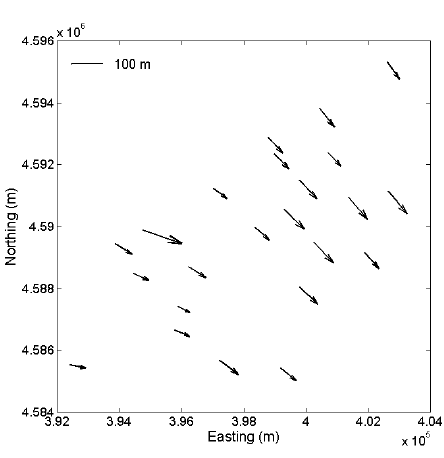
Figure 6. Absolute accuracy. Vector directions are from the geographic coordinates at image to the ones obtained by GNSS (±56.6 m in East, ±47.6 m in North).In this case, the standard deviation is estimated as ±7.4 pixels.